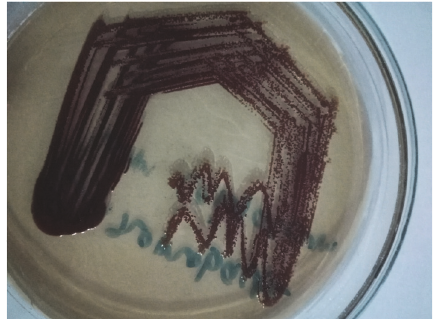
Figure 2: Colonies of Chromobacterium violaceum in MacConkey